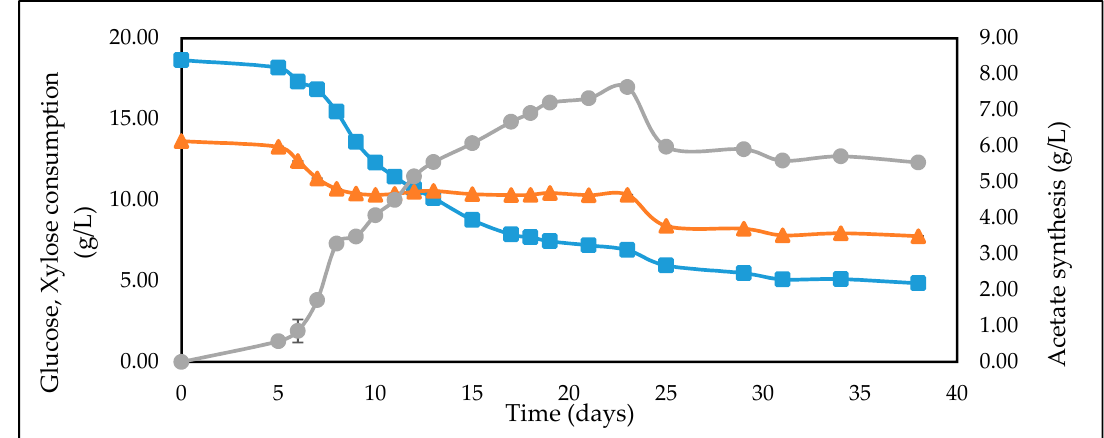
Figure 5. Time-based profile of: glucose uptake (g/L) ( (cid:4) ), xylose uptake (g/L) ( (cid:78) ) and acetic acid production (g/L) ( (cid:108) ) for WSH. (all the standard deviations were less than 5% and cannot be seen in the graph).